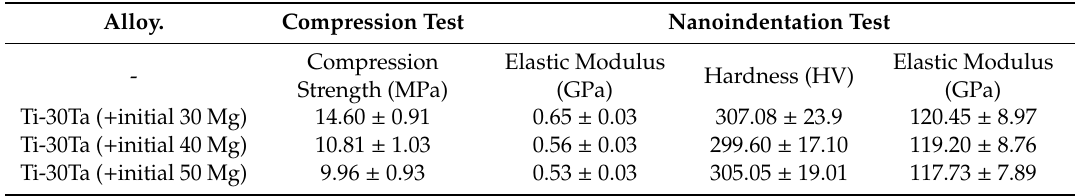
Table 2. Mechanical properties of alloys after sintering / dealloying process.